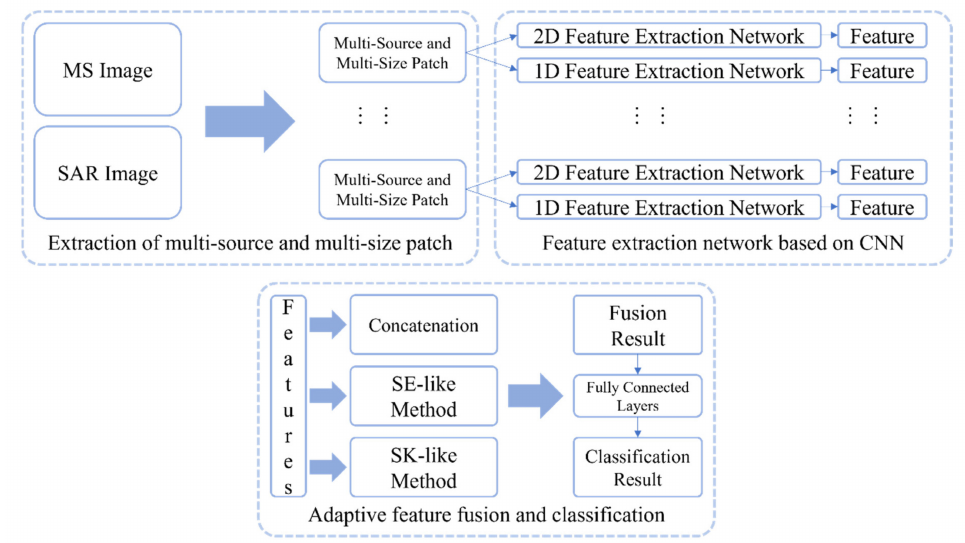
Figure 6. Methods and processes proposed in this